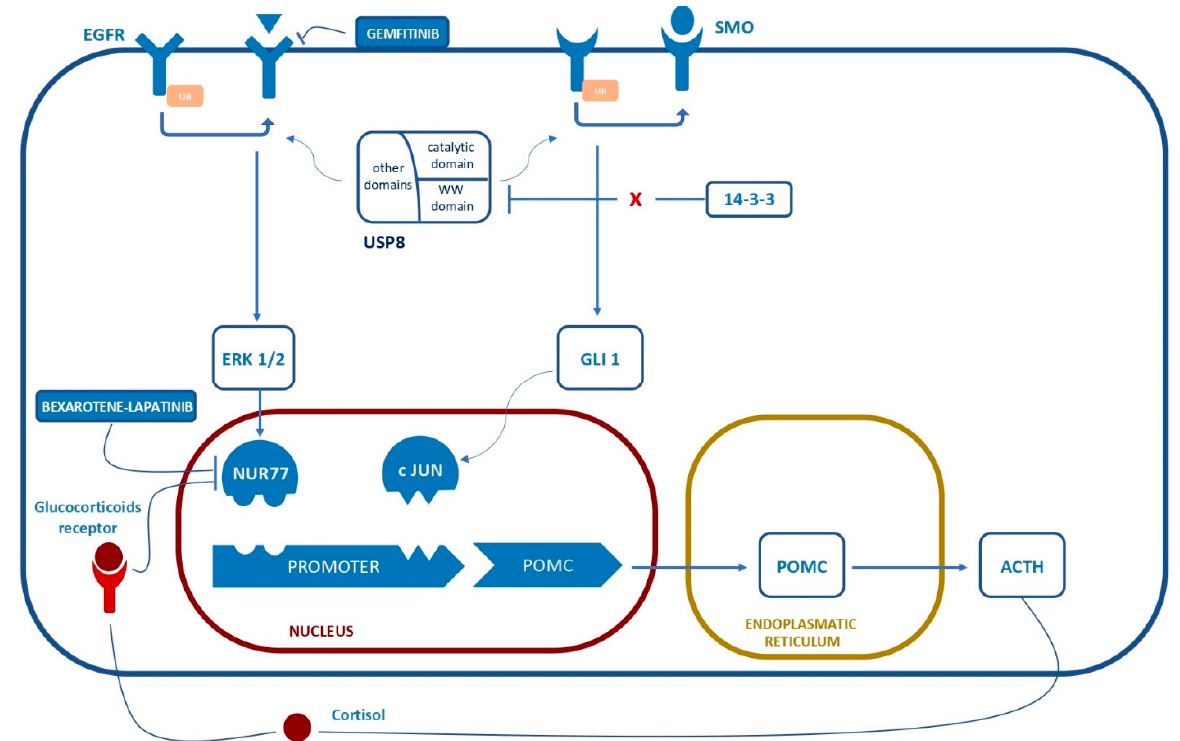
Figure 1. The outline of the relevant pathways involved in ACTH secretion related to the described mutations and potential druggable